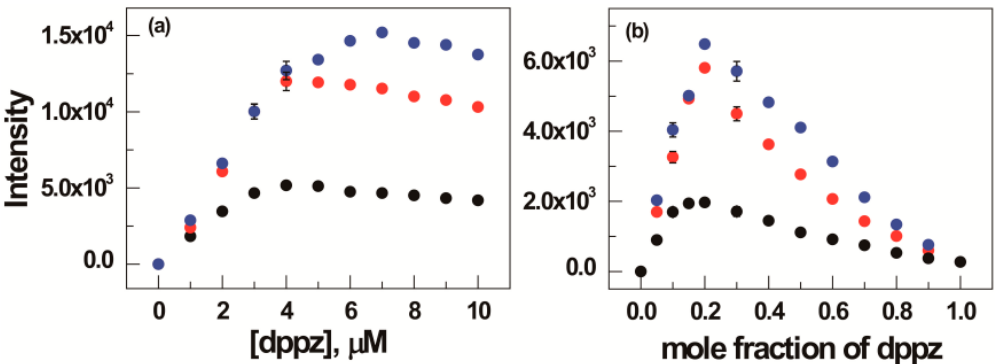
Figure 4. ( a ) Change in emission intensity of the bis ‐ Ru ‐ bpp with increasing complex concentration. Slit widths for both excitation and emission were 10 nm. [DNA] = 10 μ M, [ bis ‐ Ru ‐ bpp] = 0.5–5 μ M with an increment of 0.5 μ M. Red, black, and blue circles denote poly[d(A ‐ T) 2 ], poly[d(G ‐ C) 2 ], and poly[d(I ‐ C) 2 ] respectively. ( b ) Job plot for complex formation of bis ‐ Ru ‐ bpp with various polynucleotides. Excitation and emission wavelengths were 440 nm and 614 nm, respectively. It is noticed that the luminescence intensity of polynucleotide bound bis ‐ Ru ‐ bpp complex was the lowest in the poly[d(G ‐ C) 2 ] case (Figure 4a). Considering the factors that the minor groove resemble for poly[d(A ‐ T) 2 ] and poly[d(I ‐ C) 2 ], while the major groove of poly[d(G ‐ C) 2 ] and